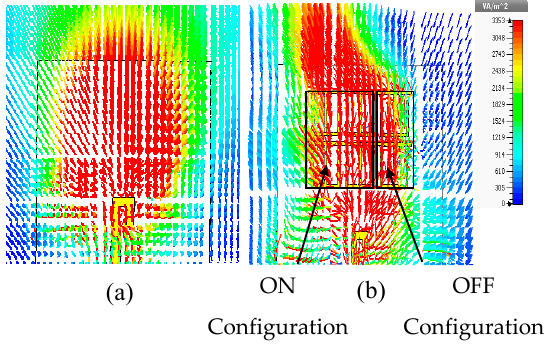
Figure 19. Radiation power flow in E-plane at 28 GHz: ( a ) dipole antenna cells; ( b ) MM antenna. Table 2. Comparison of the present work with that reported literature for beam deflection using MM structures. SSR = split-ring resonator.